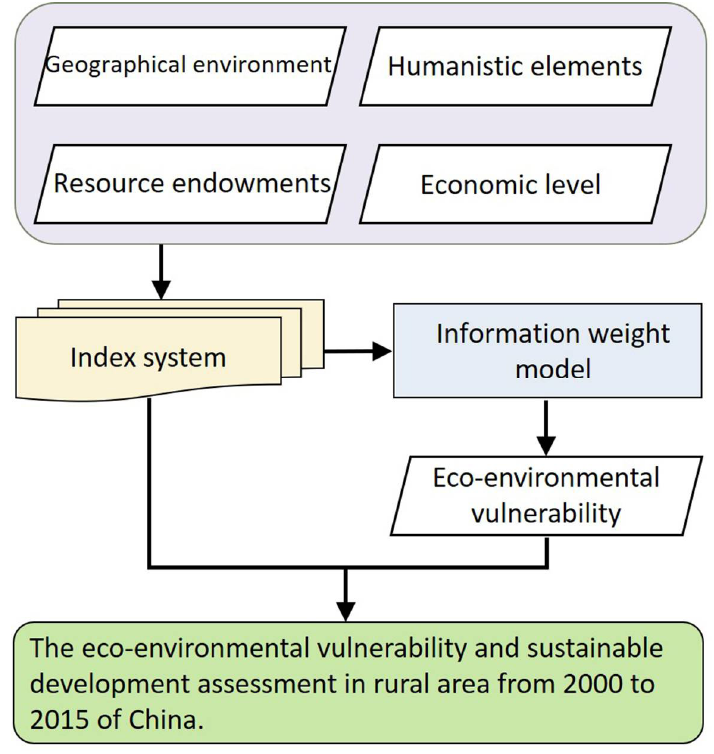
Figure 3. Framework of the study.